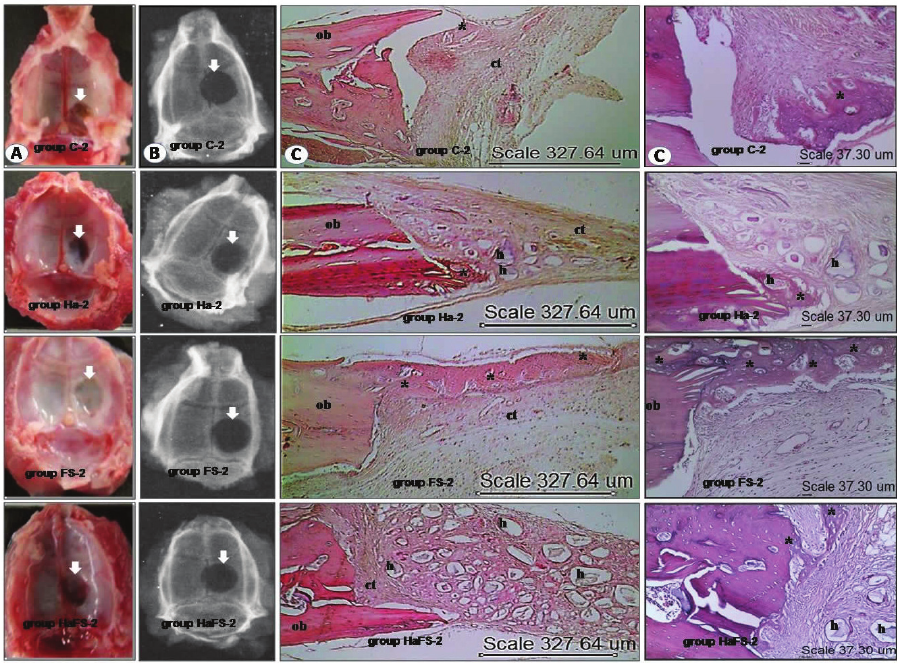
Figure 4. (A) Macroscopic, (B) radiologic and (C) histologic images obtained for animals of the four groups sacrificed 2 weeks (C-2, HA-2, FS-2, HAFS-2) after surgical creation of a parietal bone defect. In A and B, observe the absence of inflammatory signs and good definition of the bone defect area. In C, a higher quantity of new bone ( * ) projecting from the borders of the original bone (ob) was observed in groups FS-2 and HAFS-2. Hydroxyapatite particles (h), connective tissue (ct).